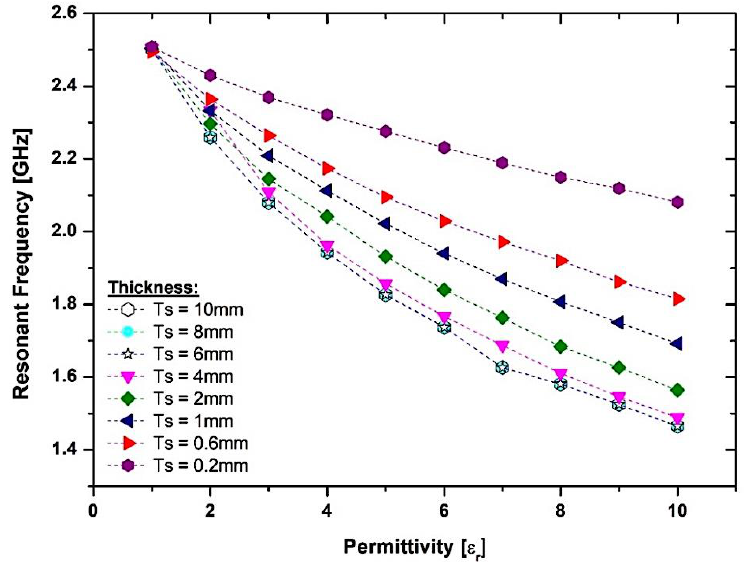
Figure 10. The effect of the change in SUT thickness (Ts) with the numerical value of real permittiv- ity .